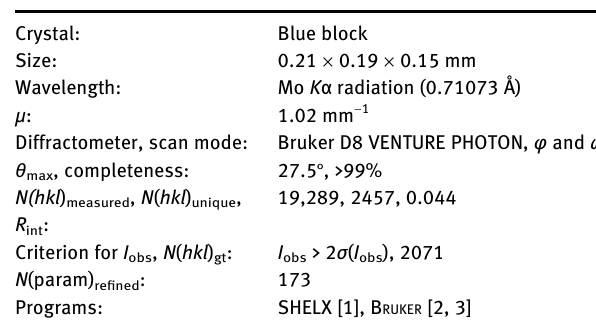
Table  : Data collection and